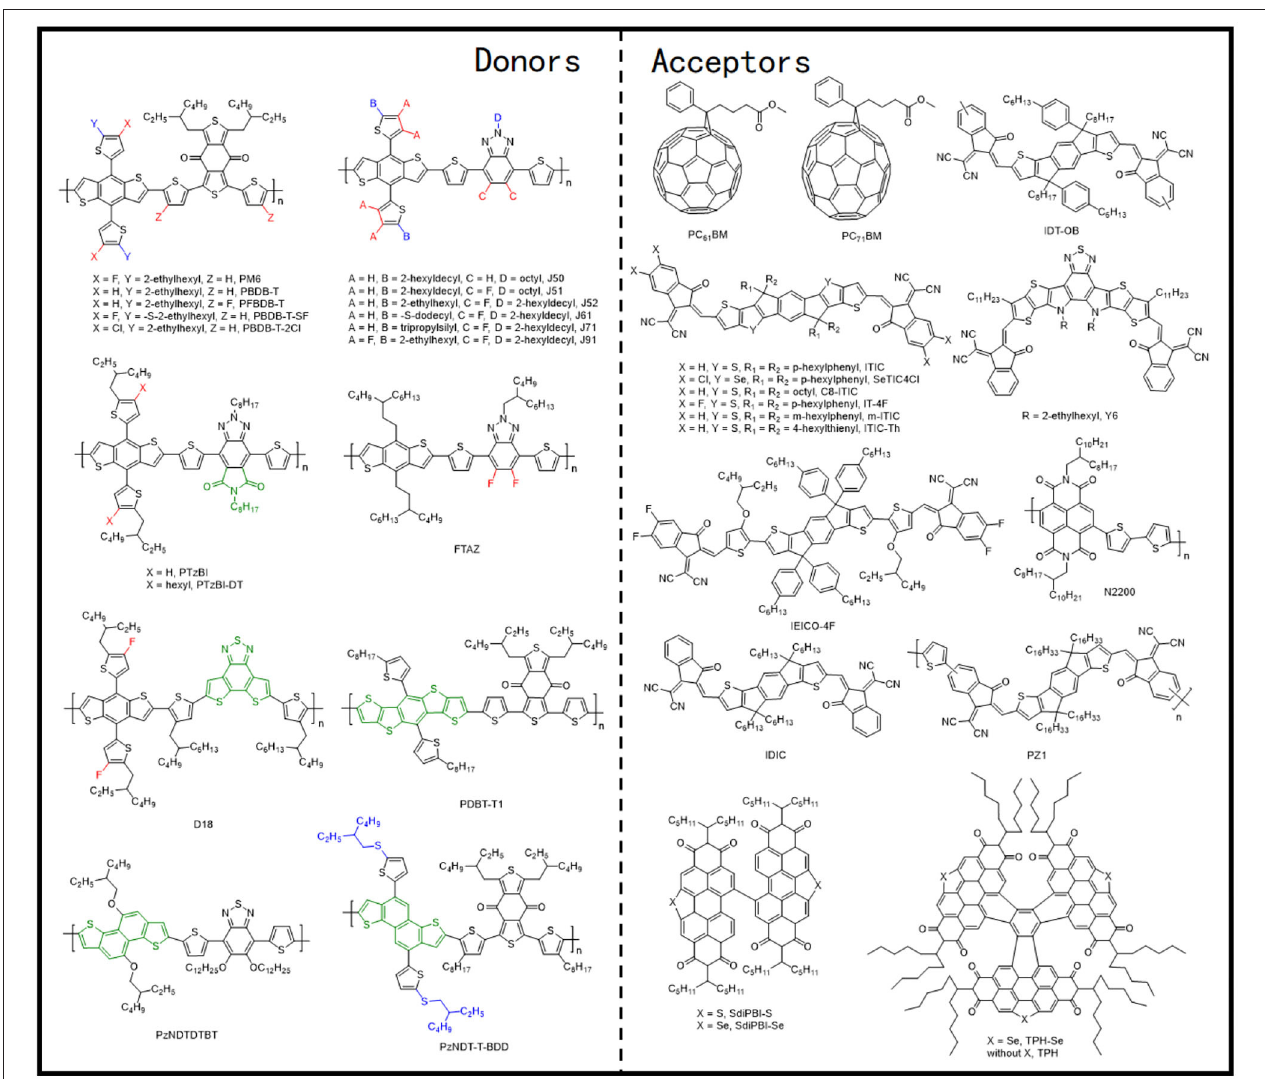
FIGURE 7 | Molecular structures of representative D– π -A copolymers with T π -bridge and mentioned